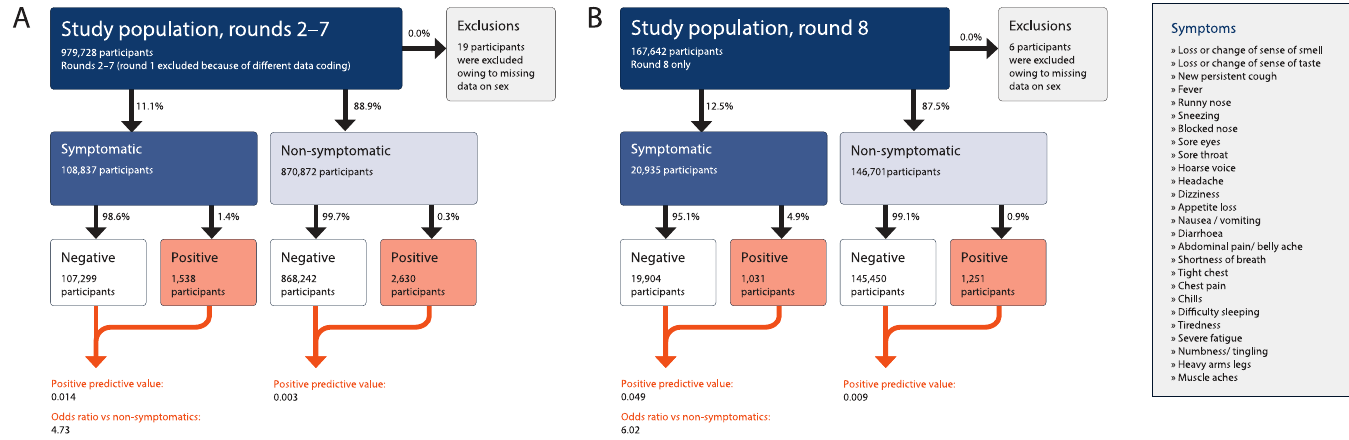
Fig 1. Flow chart showing numbers of participants by symptom status and PCR result. (A) Rounds 2–7 and (B) round 8 of the REACT-1 study.